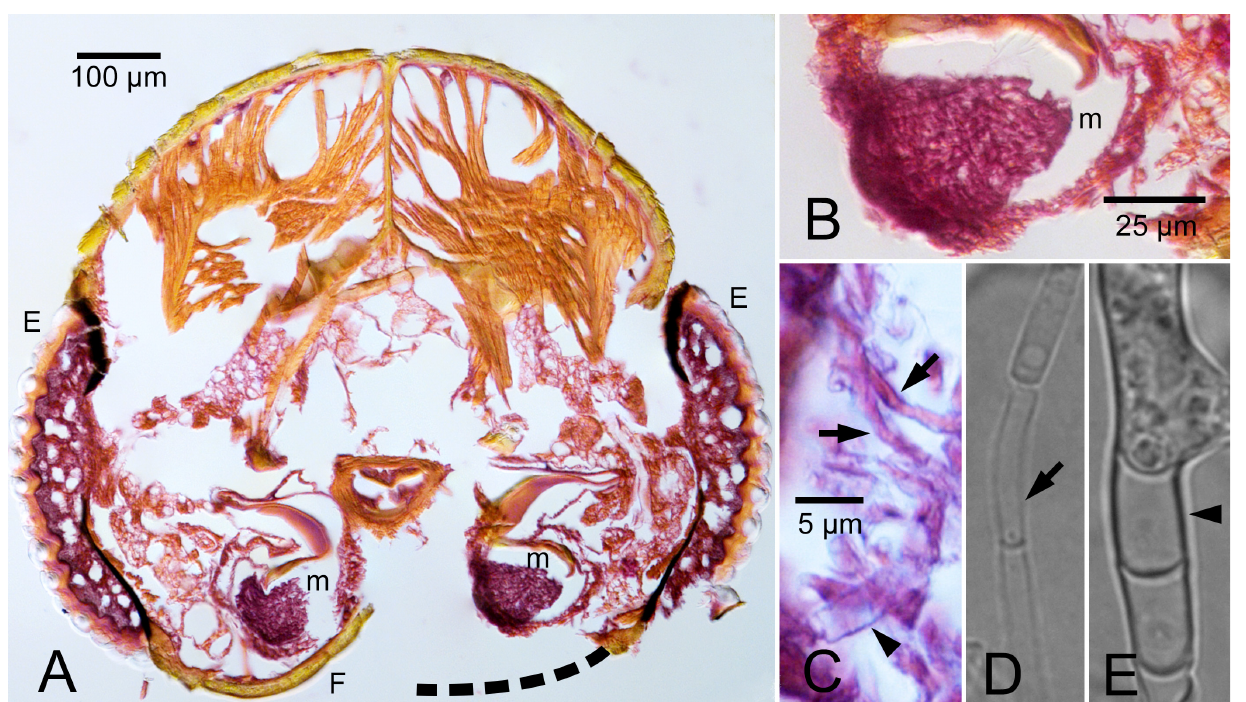
Fig 4. Transverse cross sections of adult female Ambrosiodmus lecontei heads showing position of mycangia within mouthparts. (A) Section showing entire head with paired mycangia behind the mandibles, with dashed line representing missing exoskeletal structure. (B) Compacted fungal hyphae constituting mycangial inoculum. (C) Loose hyphae from mycangial packet, with both small (arrows) and larger (arrowhead) hyphae, likely representing dimitic generative and skeletal hyphae, respectively. (D& E) Flavodon cf. flavus isolate 6860_sub_white_myce with dimitic generative (D) and skeletal (E) hyphae. Key: E, eye; F, frontal edge (accidentally damaged); m, mycangium.